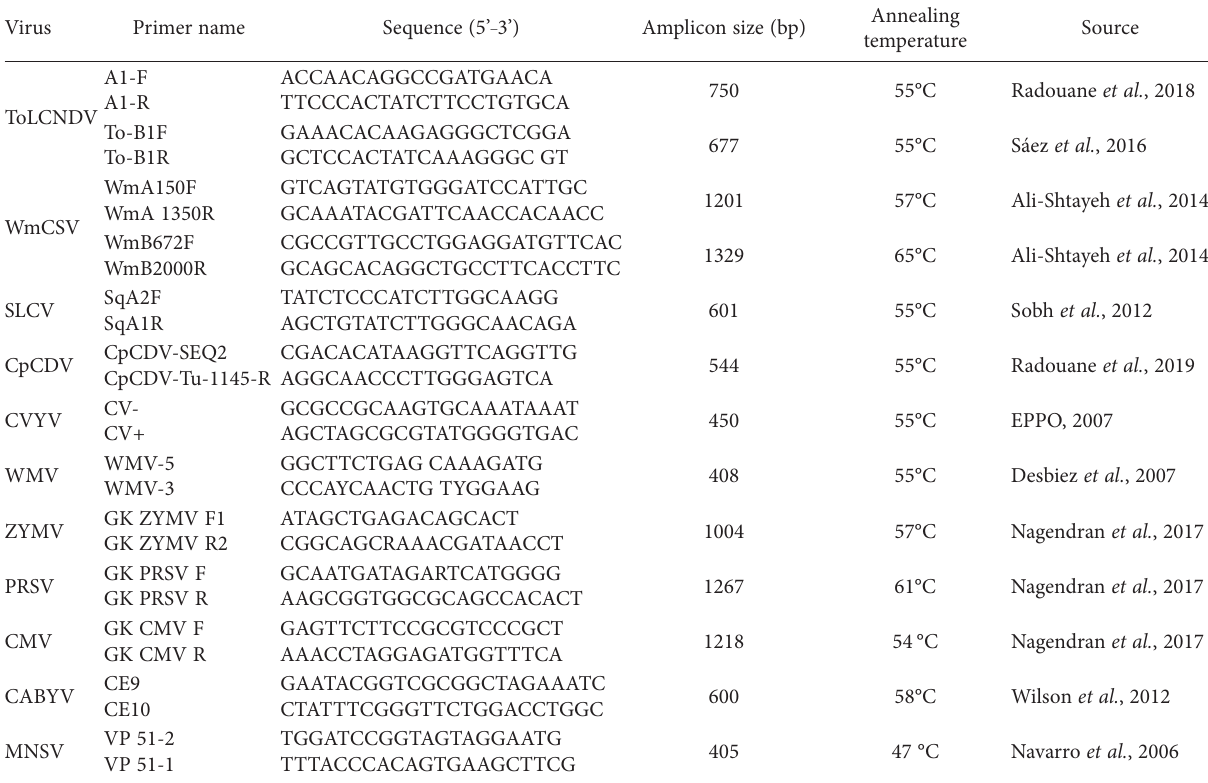
Table 3. Primers used for the detection of viruses.